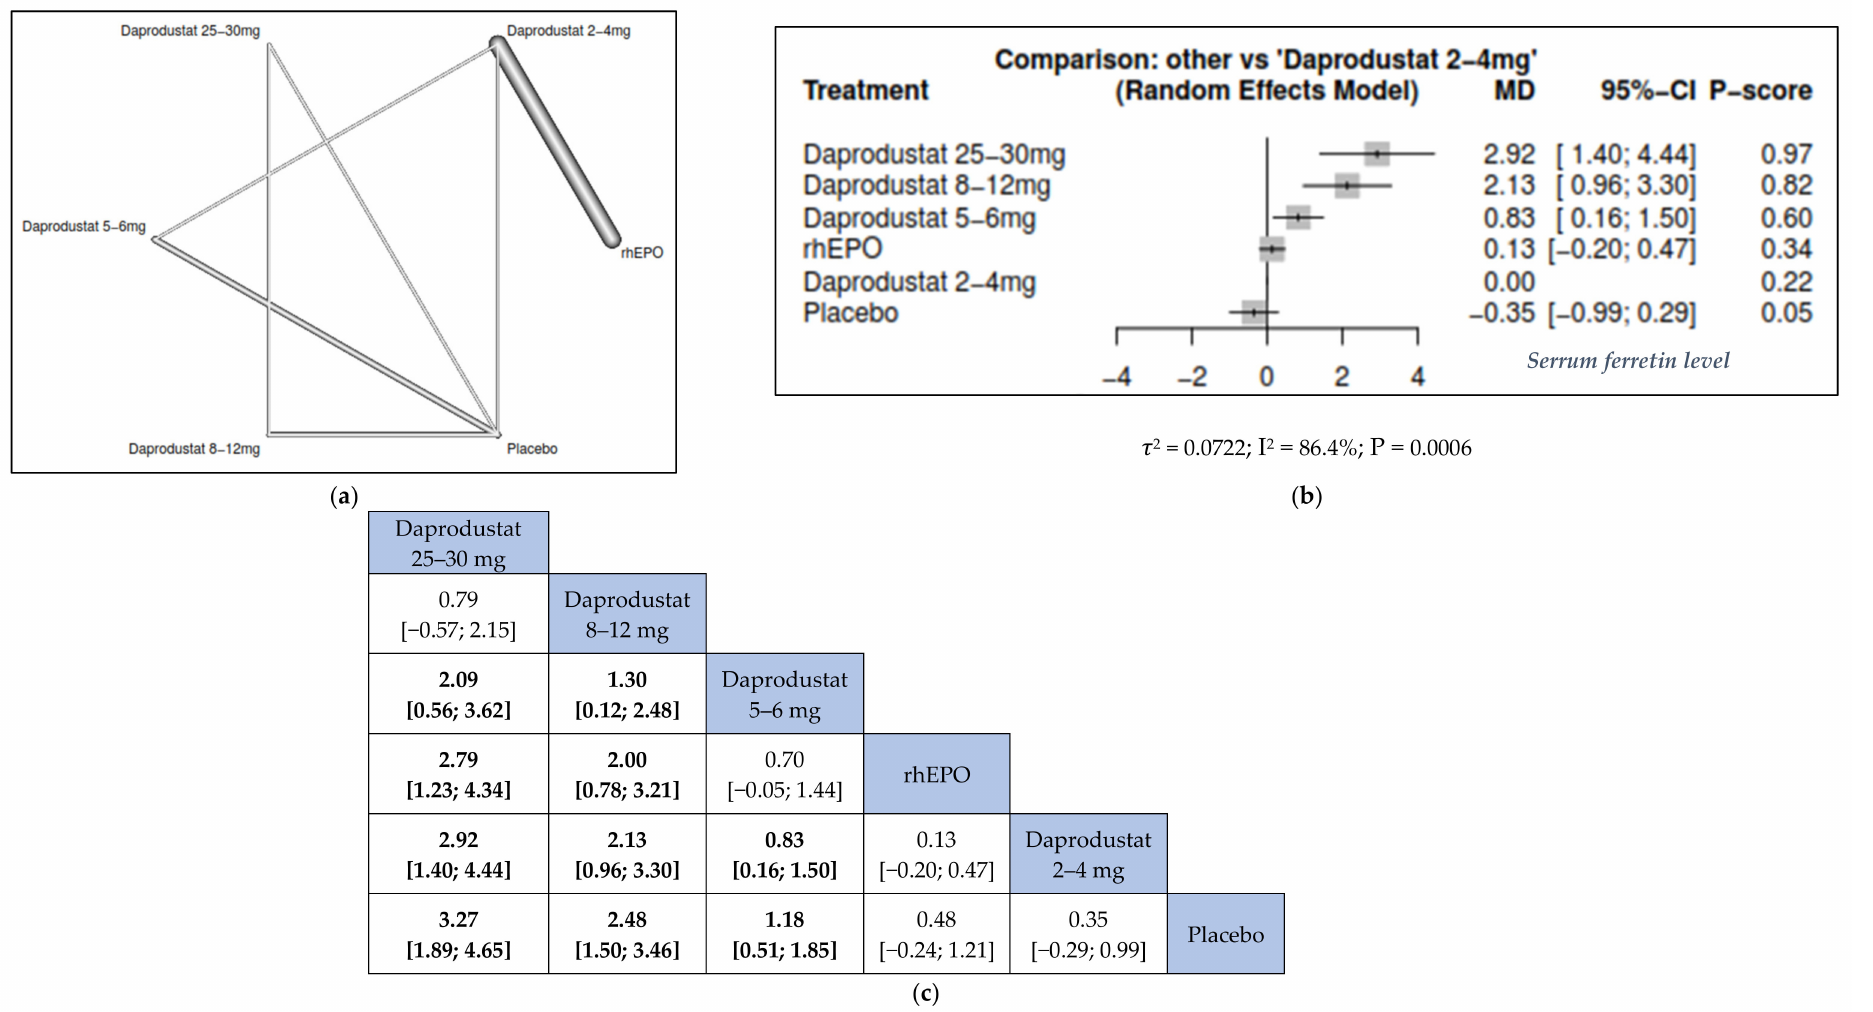
Figure 3. Network meta-analysis results of serum HB. ( a ) Network graph showing direct evidence between the assessed interventions. ( b ) A forest plot was generated by comparing all interventions with “placebo”; P-score was used for ranking. ( c ) The league table represents the network meta-analysis estimates for all interventions comparisons; the results are the mean difference (MD) with 95% CI, bold items are statistically